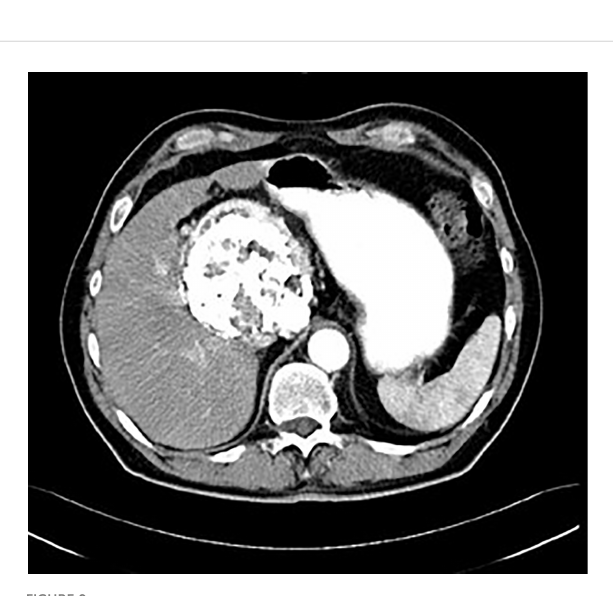
FIGURE 9 Postcontrast CT of unicentric form of Castleman disease - atypical fi nding of calci fi ed mass in subhepatic space, histology: hyaline- vascular